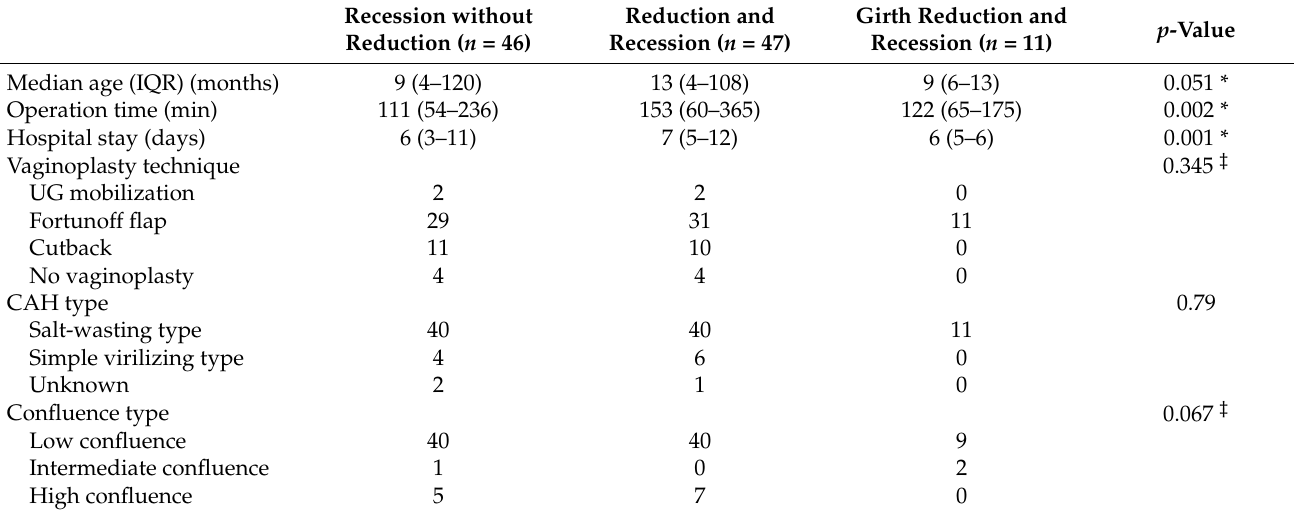
Table 2. Surgical details of the clitoroplasty